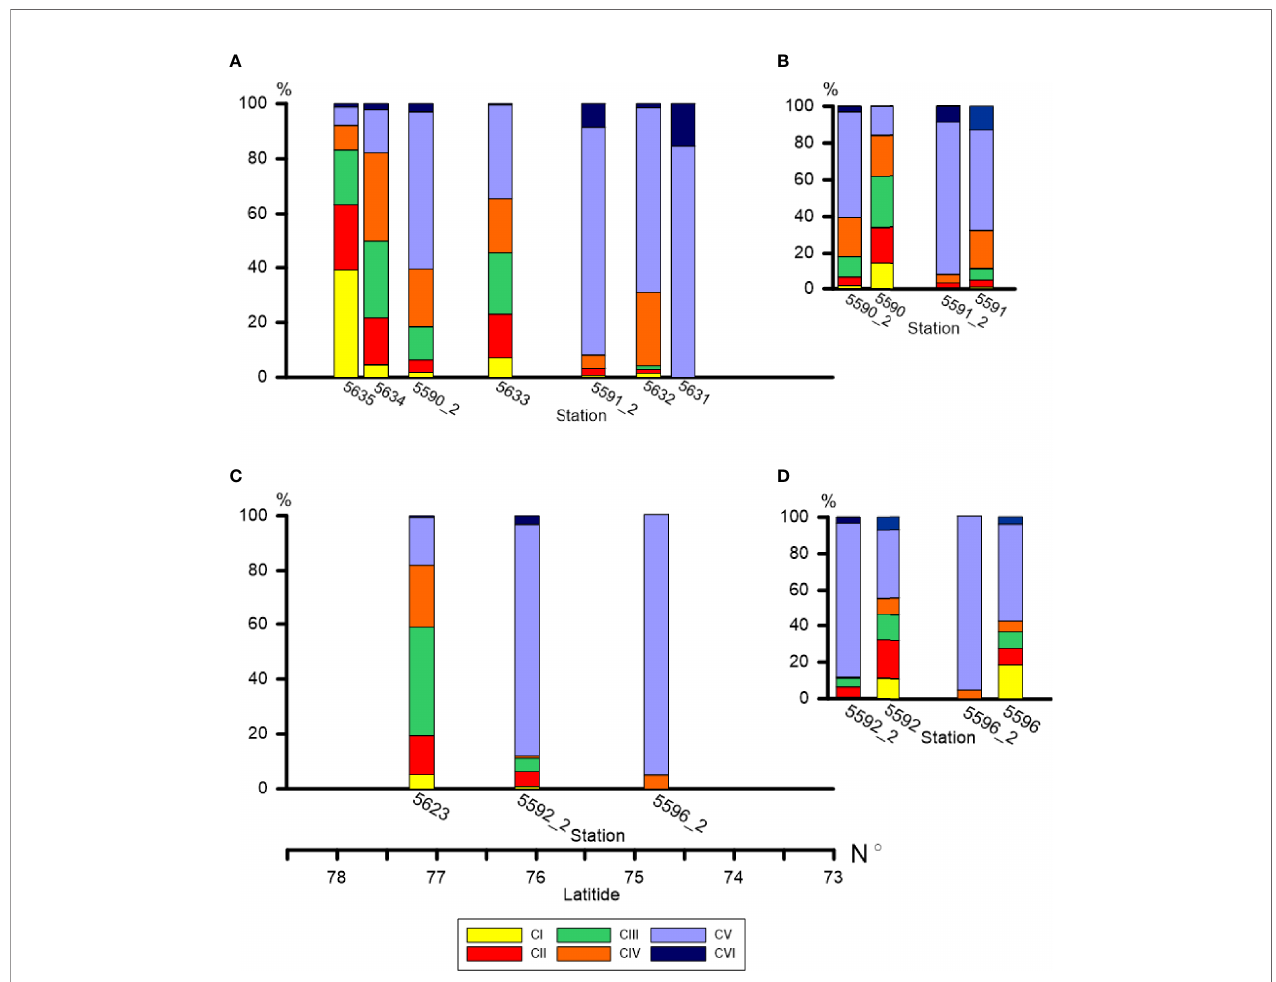
FIGURE 7 | Demographic structure of C. glacialis population (relative abundance of each copepodite stage as percent of total population abundance) along the Khatanga (A) and Lena (C) transects and at the repeated stations in the Khatanga area (B) and in the Lena area (D) . Spatial and temporal changes in dominance of consecutive copepodite stages is clearly